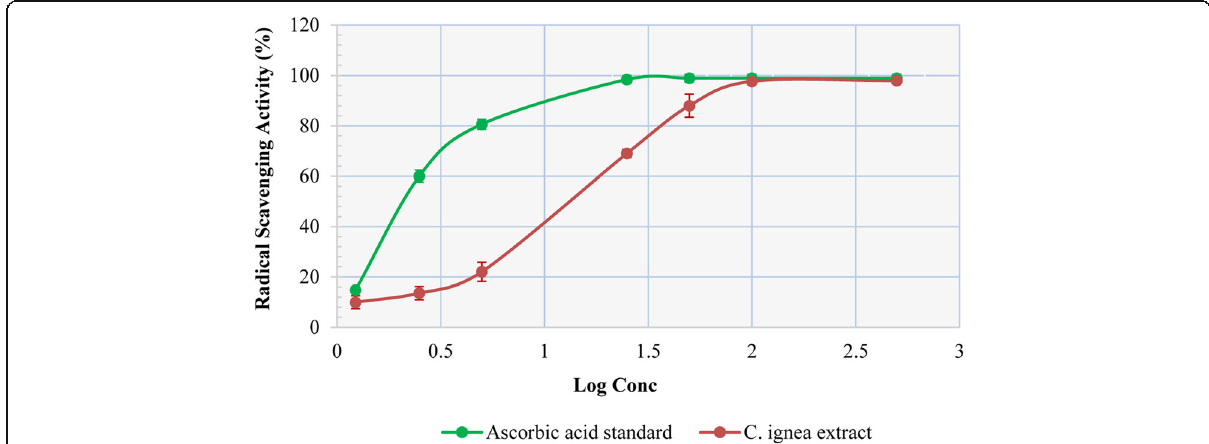
Fig. 1 Radical scavenging activity of C. ignea aerial parts extract in comparison to ascorbic acid . Results are given as mean ± SD of 3 independent experiments. RSA with 98% considered as a full absorbance inhibition of scavenging radical because absorbance inhibition of the final solution will never reach 100%